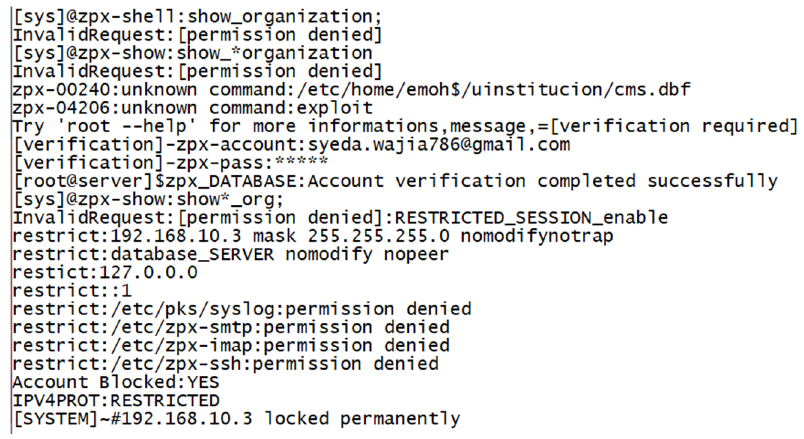
Figure 13. Countries connected to cloud servers.